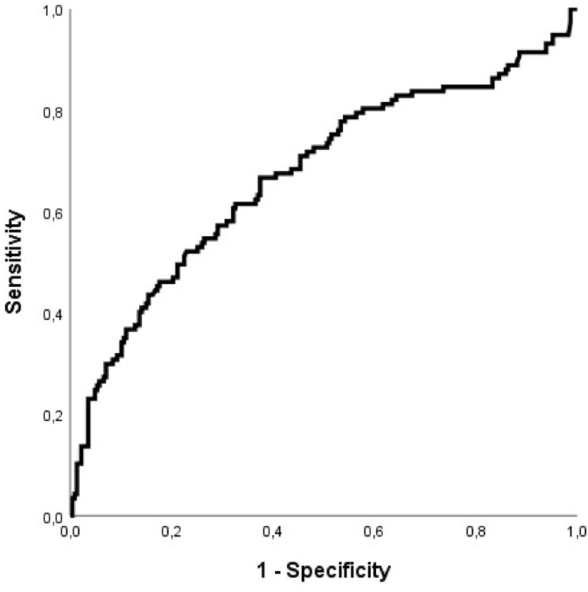
Figure 3. ROC curve shows moderate discrimination of baseline Fibrinogen–Albumin-Ratio for in-hospital thromboembolic complications (AUC = 0.67 [95% CI 0.61–0.74]).